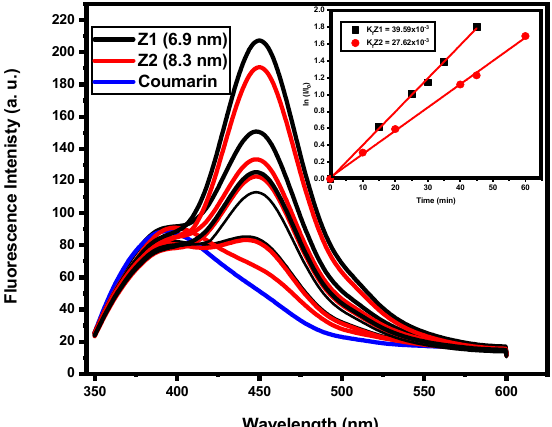
Figure 7. Emission spectra and kinetics plot of coumarin in the presence of ZQDs.